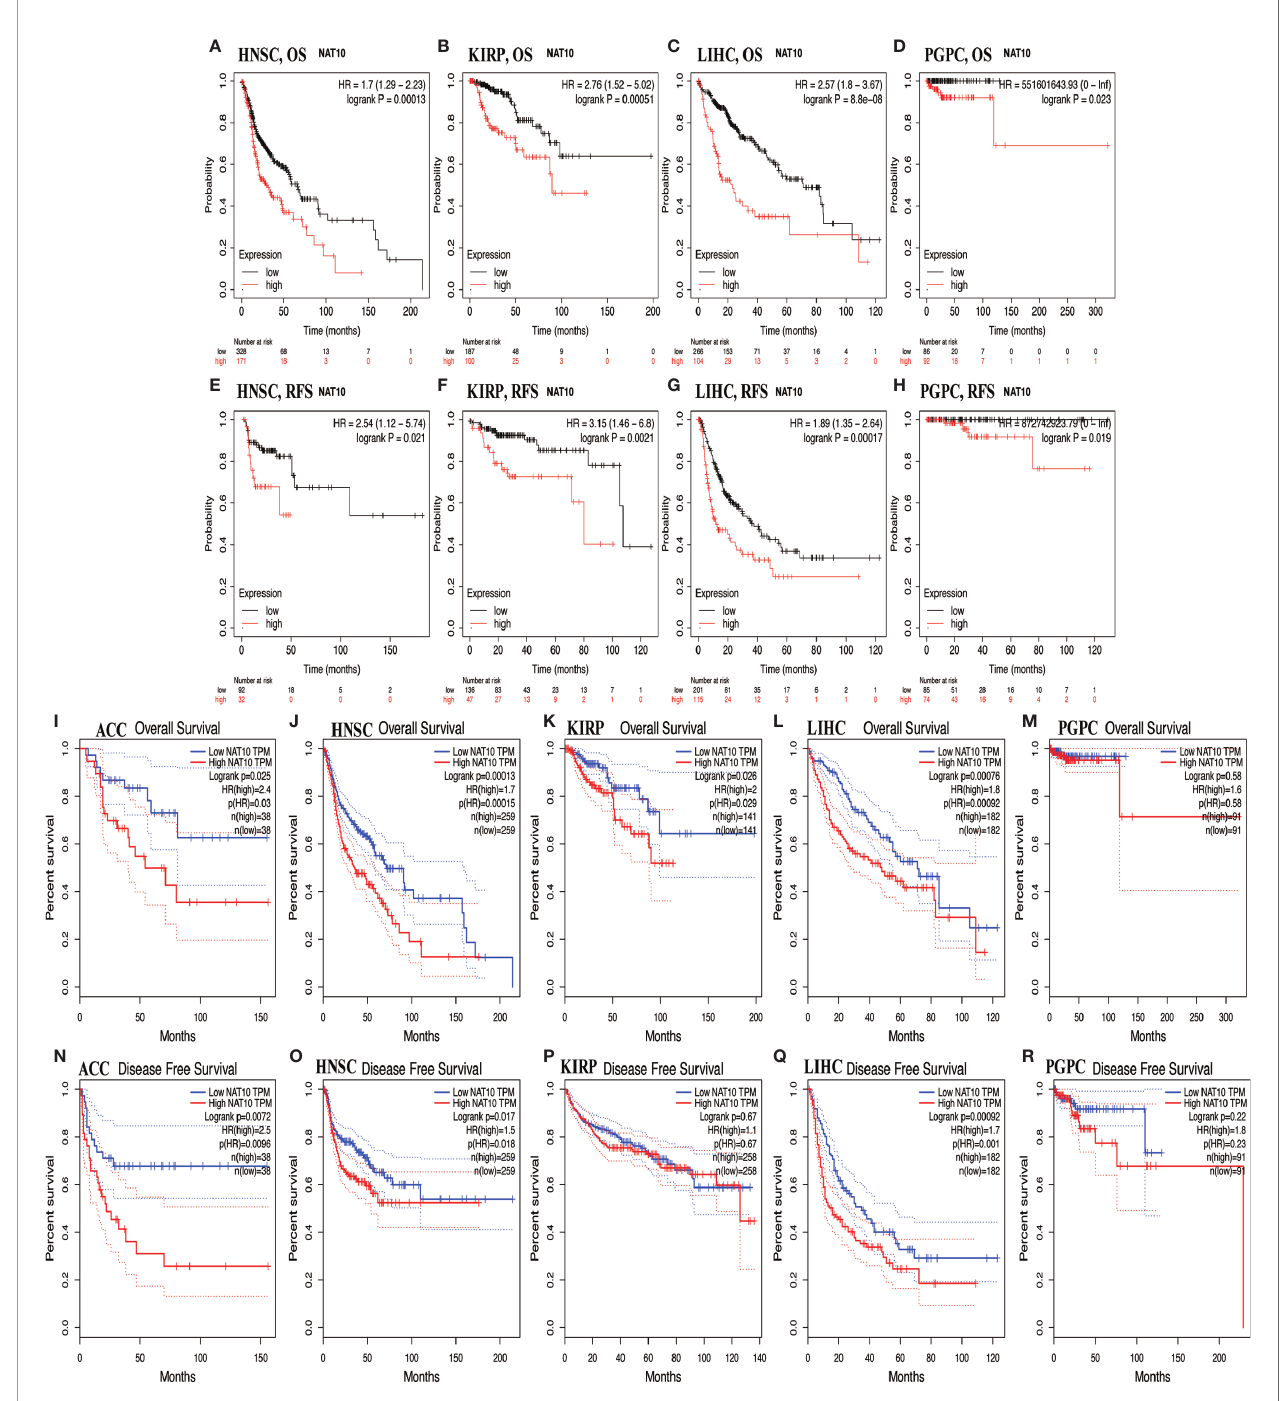
FIGURE 3 | Kaplan-Meier survival curves comparing NAT10 expression in ACC, HNSC, KIRP, LIHC, and PCPG in GEPIA2 and Kaplan-Meier Plotter. (A – D) Differences in OS among groups in HNSC (A) , KIRP (B) , LIHC (C) , and PCPG (D) in Kaplan-Meier Plotter. (E – H) Differences in RFS among groups in HNSC (E) , KIRP (F) , LIHC (G) , and PCPG (H) in Kaplan-Meier Plotter. (I – M) Differences in OS among groups in ACC (I) , HNSC (J) , KIRP (K) , LIHC (L) , and PCPG (M) in GEPIA2. (N – R) Differences in DFS among groups in ACC (N) , HNSC (O) , KIRP (P) , LIHC (Q) , and PCPG (R) in